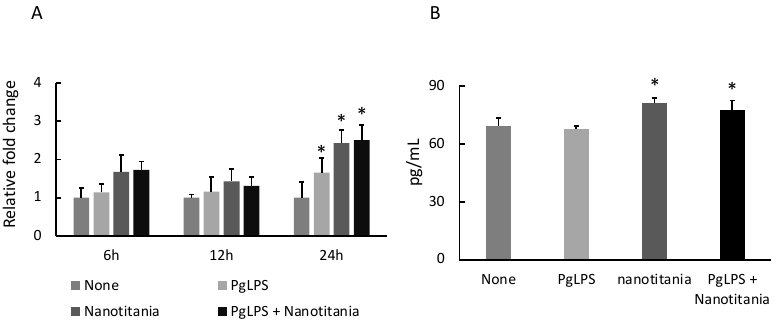
Figure 6. Expression levels of IL-11 mRNA ( A ) and protein levels ( B ) of IL-11 were measured by qPCR or ELISA, respectively, after incubation with 10 µg/mL PgLPS, 10 µg/mL nanotitania and both stimulants together. Each data point indicates the average of six gene expression quantification results (n = 6). Bars indicate standard deviation, and asterisks indicate p < 0.05.